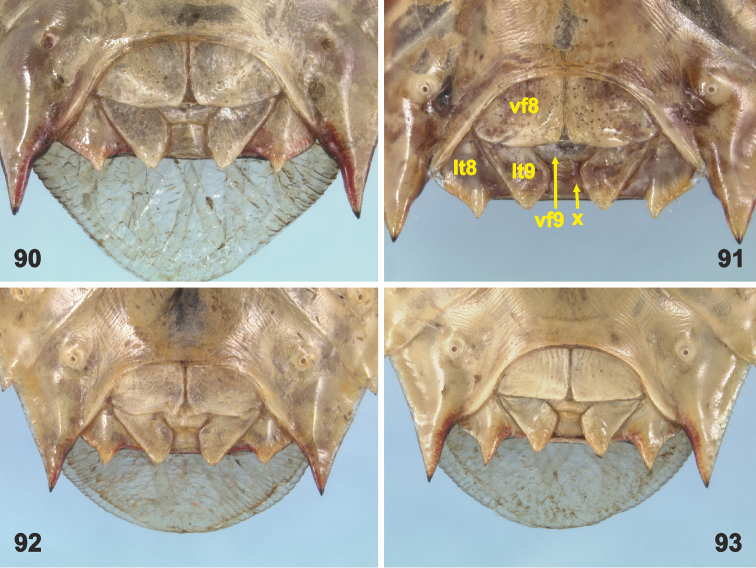
Female external genitalia in ventro-posterior view. 90Rh.grandicallosagrandicallosa Bergroth, 1911 91Rh.grandicallosacentroamericana subsp. n. 92Rh.henryi sp. n. 93Rh.meinanderi Becker & Grazia-Vieira, 1971. Not to scale. Abbreviations: lt8–9 laterotergites VIII and IX, vf8–9 valvifers VIII and IX, x segment X. (photographs: J.E. Eger)